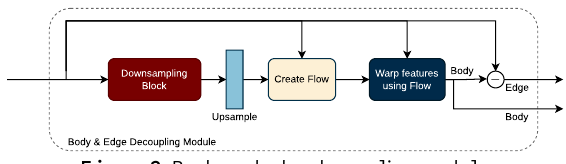
Figure 2. Body and edge decoupling module.